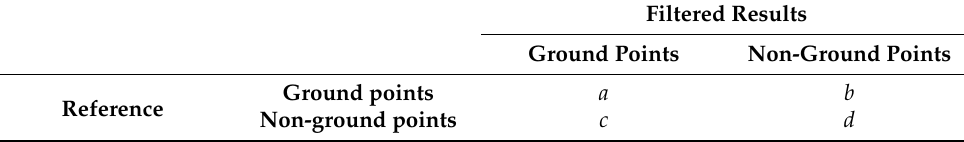
Filtered Results